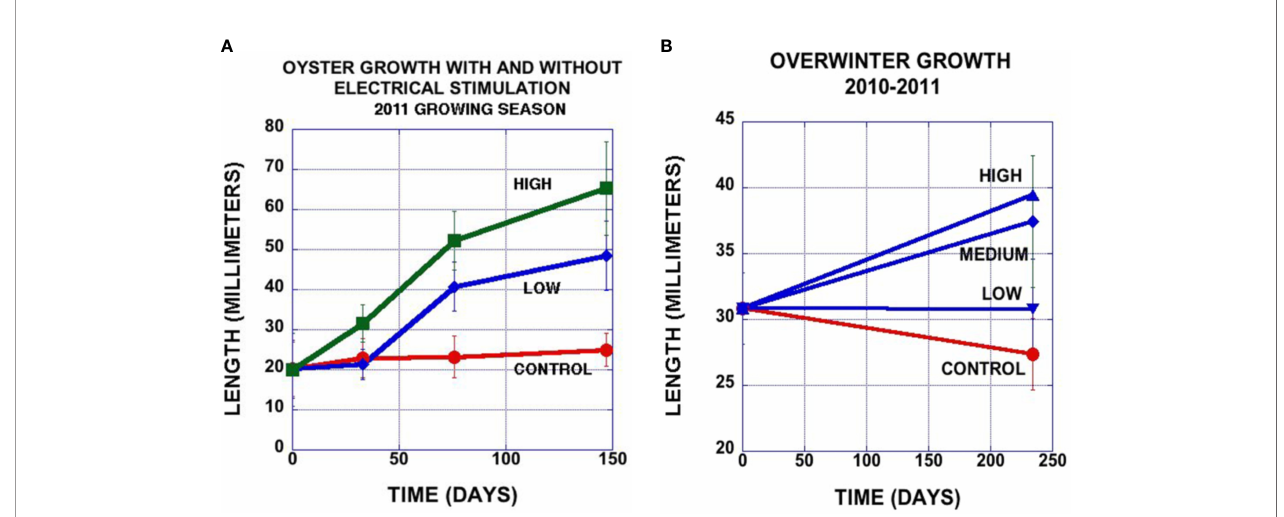
FIGURE 13 | (A) Summer growth of oysters with high, low, and no electricity. Data from Shorr et al., 2012. (B) Growth of oysters over winter with high, medium, low, and no electrical current. All high current Biorock oysters survived and kept growing all winter long. 93% of control oysters died, and the survivors all went dormant and shrank in size as their shells dissolved in cold acidic water. Data from Shorr et al.,